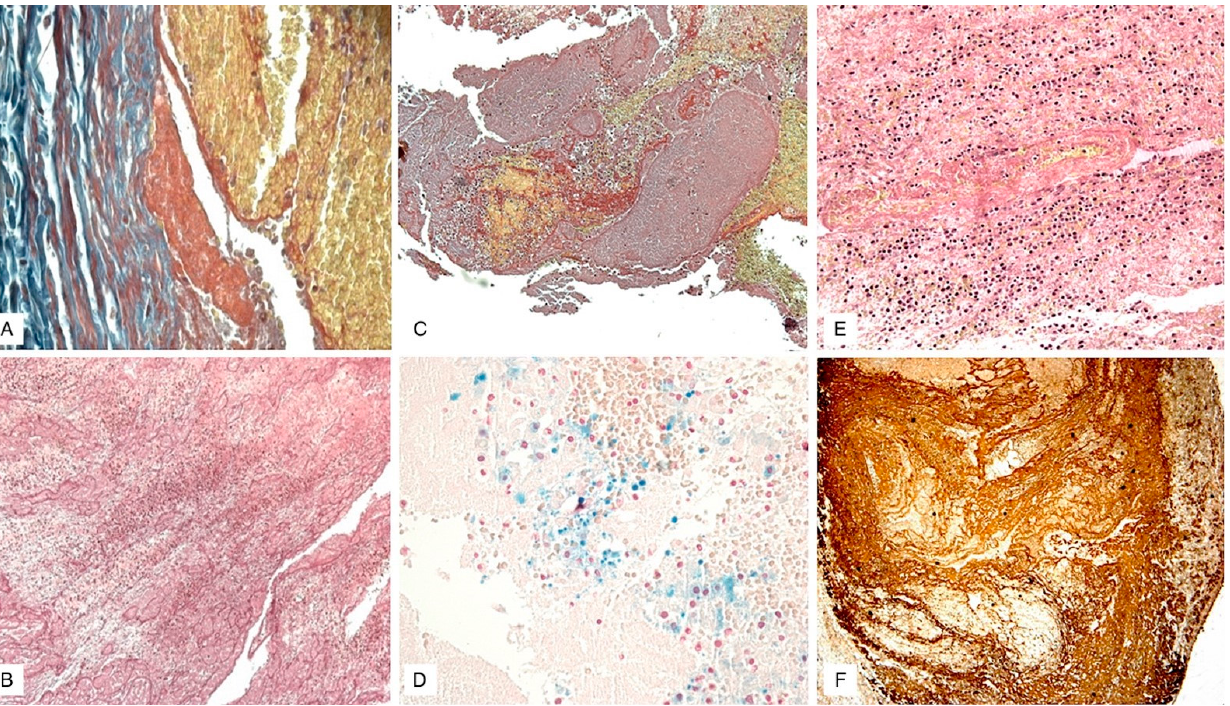
Figure 3. Images of the chronology of the microscopic changes related to the organization of the thrombus, according to Table 3. (( A , B ) Phase 1, Mallory trichrome and phosphotungstic acid-hematoxylin (PTAH) staining; 100 × , 60 × . ( C , D ) Phase 2, Van Gieson and Perls’ iron staining; 60 × , 100 × . ( E , F ) Phase 3, Van Gieson and Weigert–Van Gieson staining; 80 × , 60 × ) [30]. All images refer to samples of thrombi from deep veins of lower limbs of human